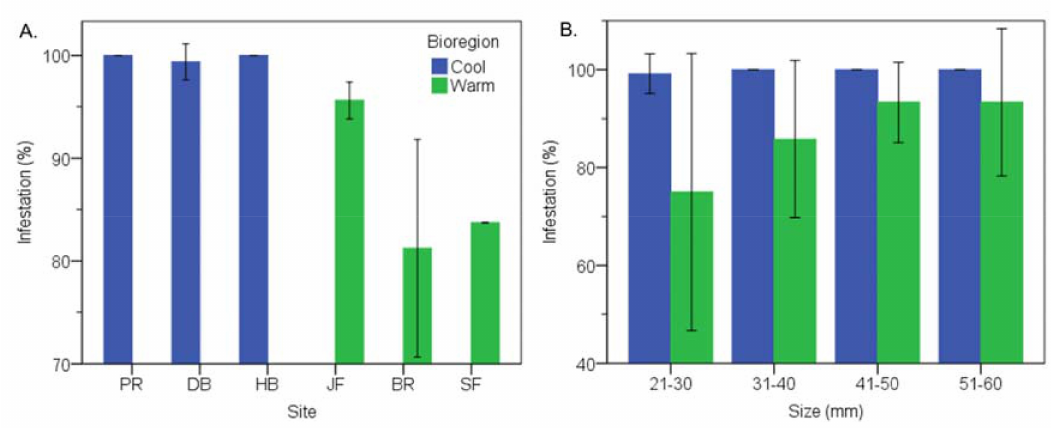
Figure 3. Overall prevalence of infestation (%; ± 95% CI) for Mytilus galloprovincialis along the cool temperate and warm temperate bioregions. Data grouped by ( A ) site with size classes pooled and ( B ) by size class with sites pooled.